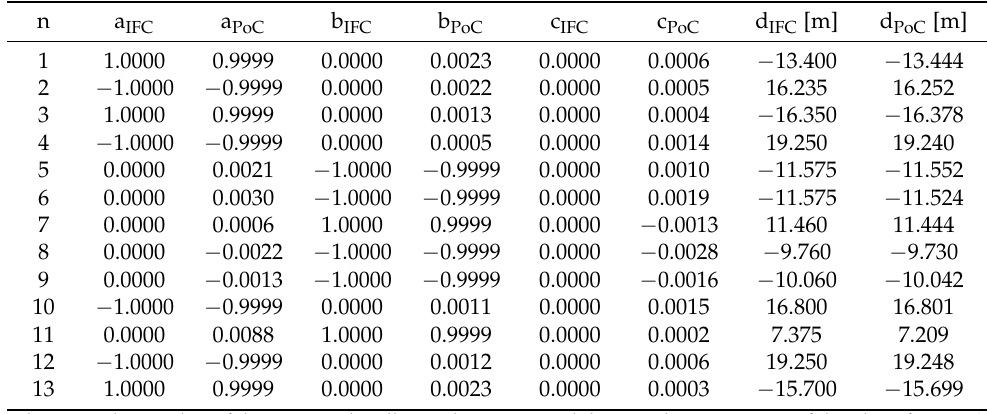
Table 1. Comparison of the plane parameters.